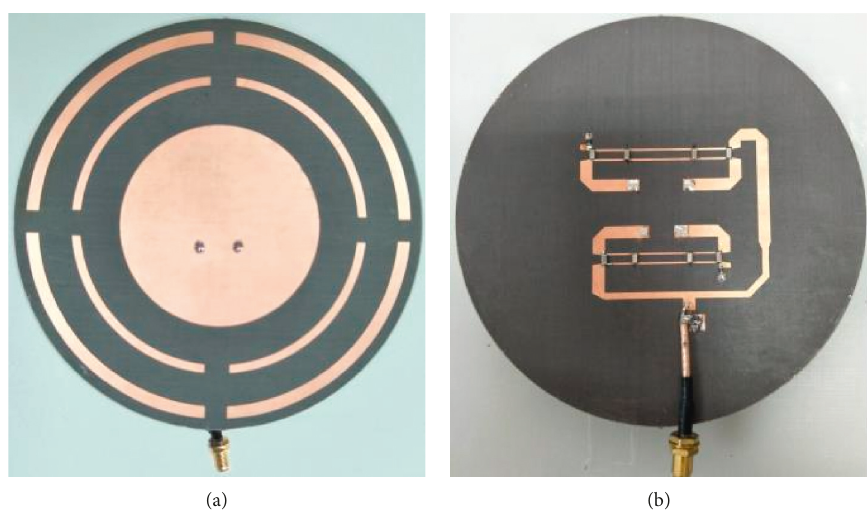
Figure 13: (a) Top and (b) bottom views of the fabricated prototype.